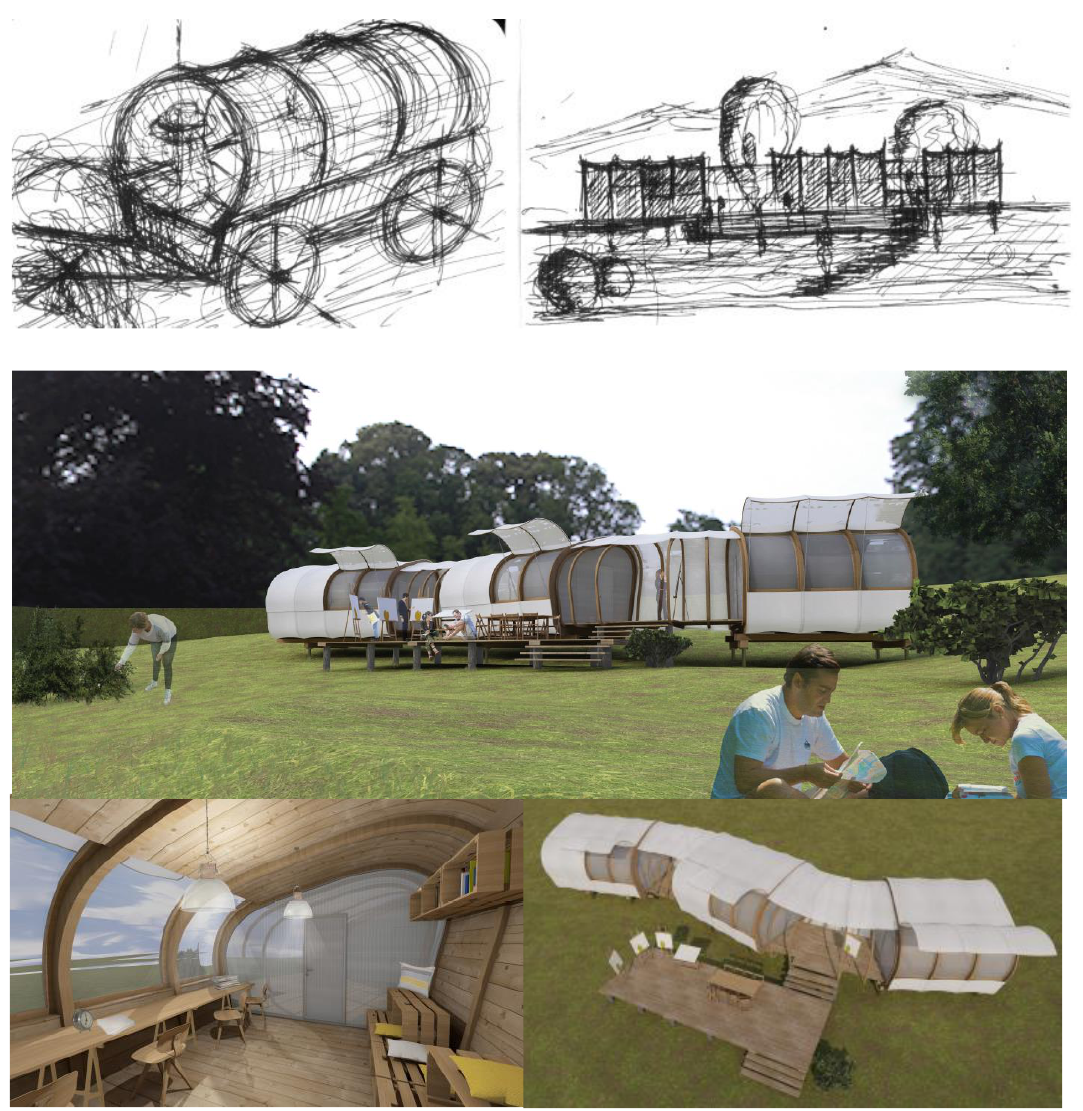
Figures 8-12: Project for Temporary Accommodation for Restorers at Roşia